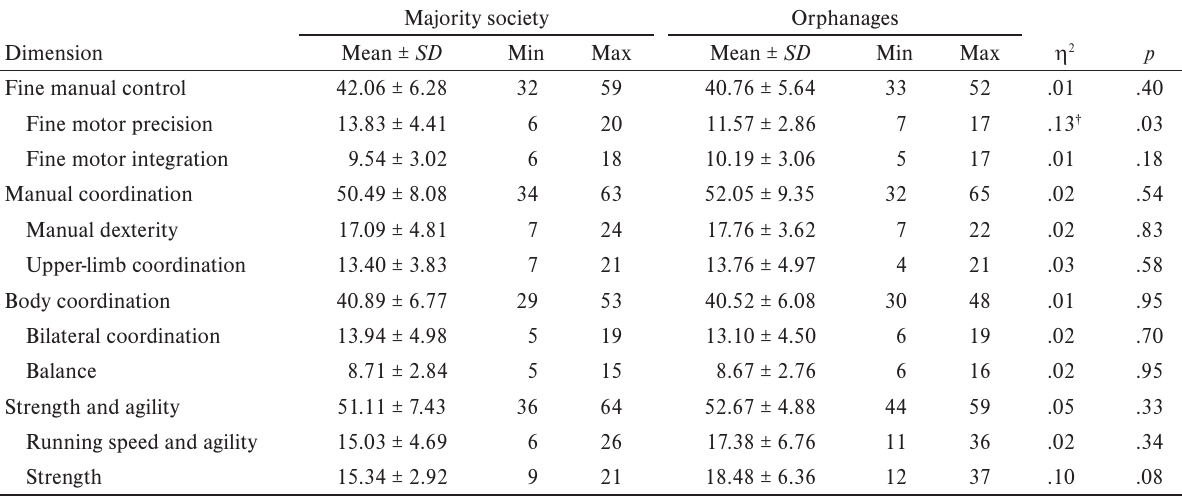
Descriptive statistics of all BOT-2 dimensions for adolescents from majority society and from orphanages Majority society Dimension